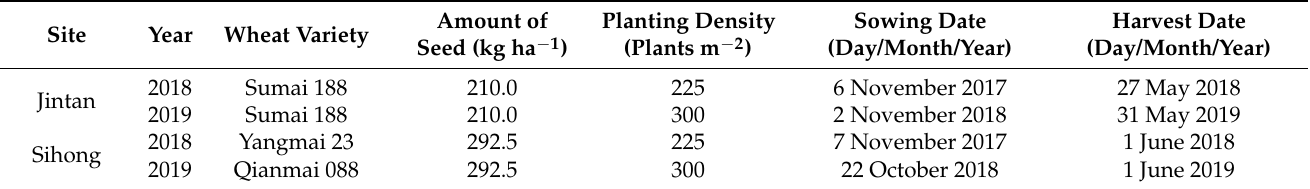
Table 1. Wheat variety, amount of seed, planting density, and sowing and harvest date of 2017–2018 and 2018–2019 at Jintan and